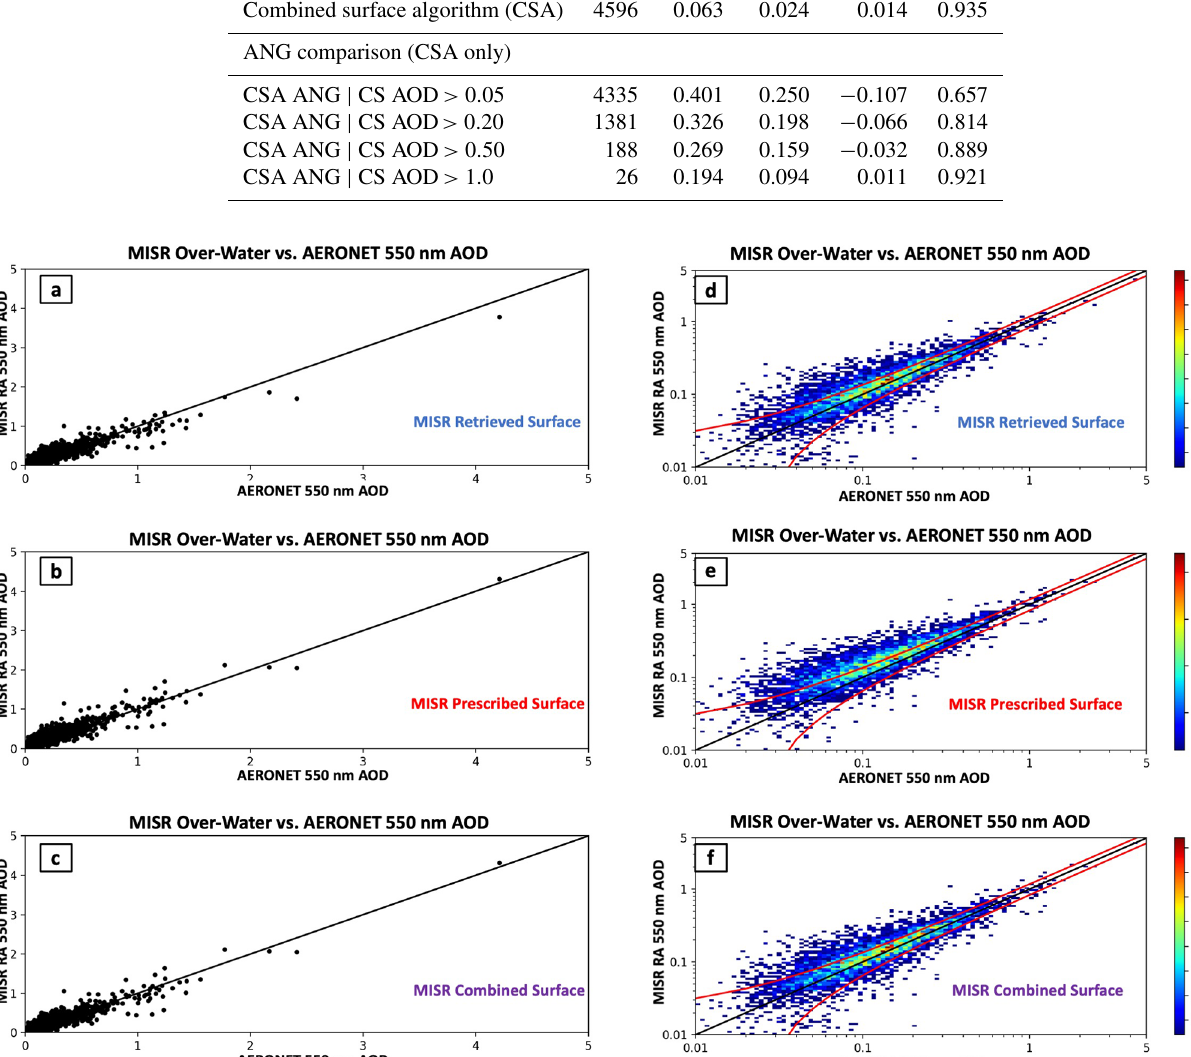
els) for each AERONET coincidence; otherwise, the spa- tially averaged MISR results are not included in the